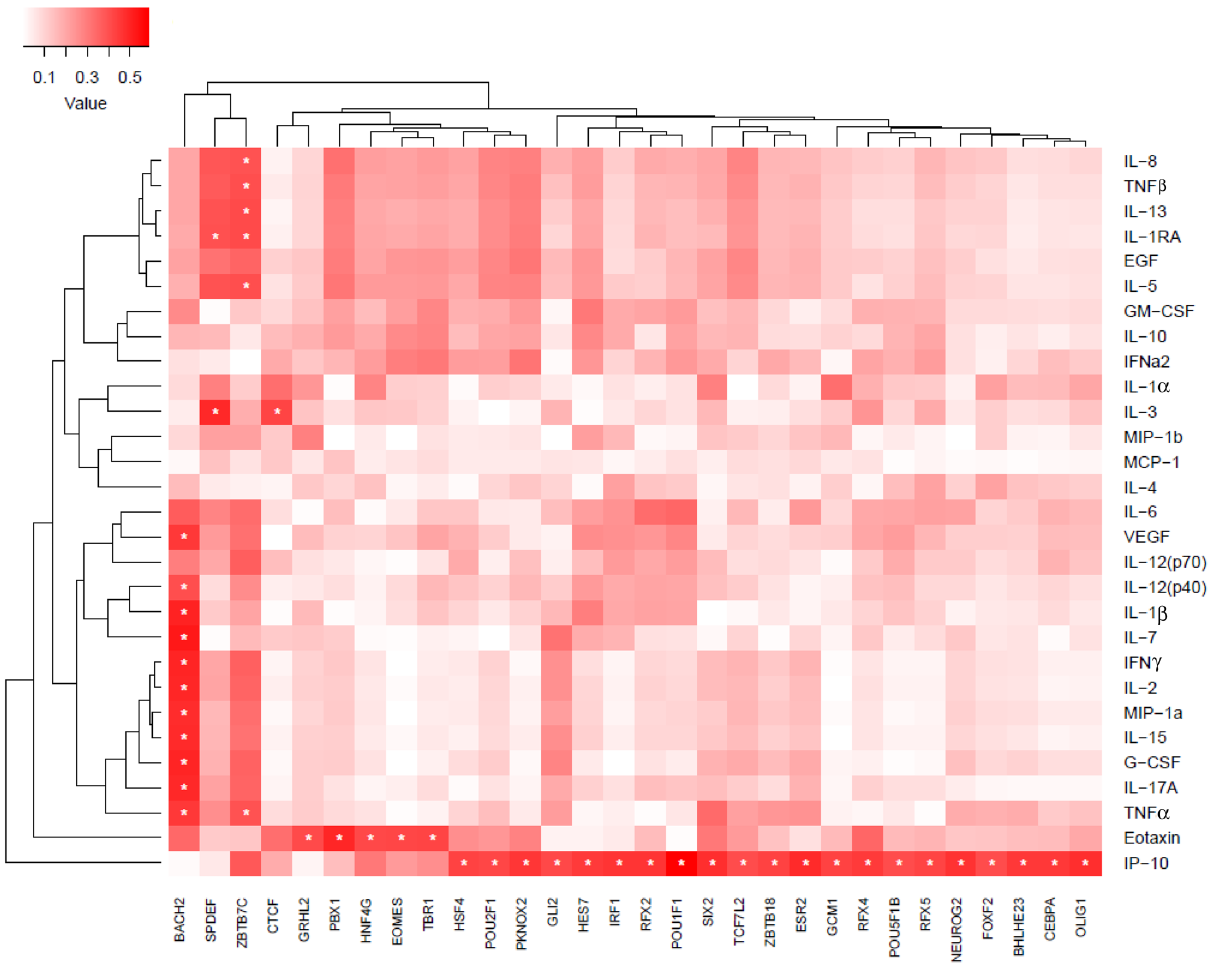
Figure 1. Association of activity of transcription factors (TFs) with cytokine and chemokine levels in plasma. Activity of the TFs was measured by single person transcription factor (spTF) scores. spTF was calculated as described in the methods. Briefly, TF targets as described in 64 were used to perform PCA and subject specific PC scores were used to calculate pearson correlation (ranging from low to high depicted by white to red color bar) with cytokine levels. The significant correlations (p < 0.05) are indicated with stars. Analysis and graphical output done using in R (ver 3.5.1) 57